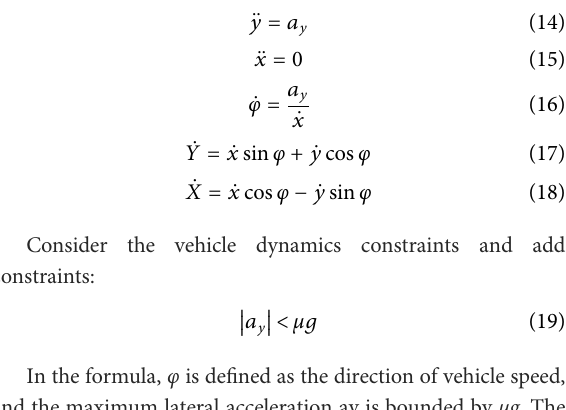
FIGURE 4 Function change